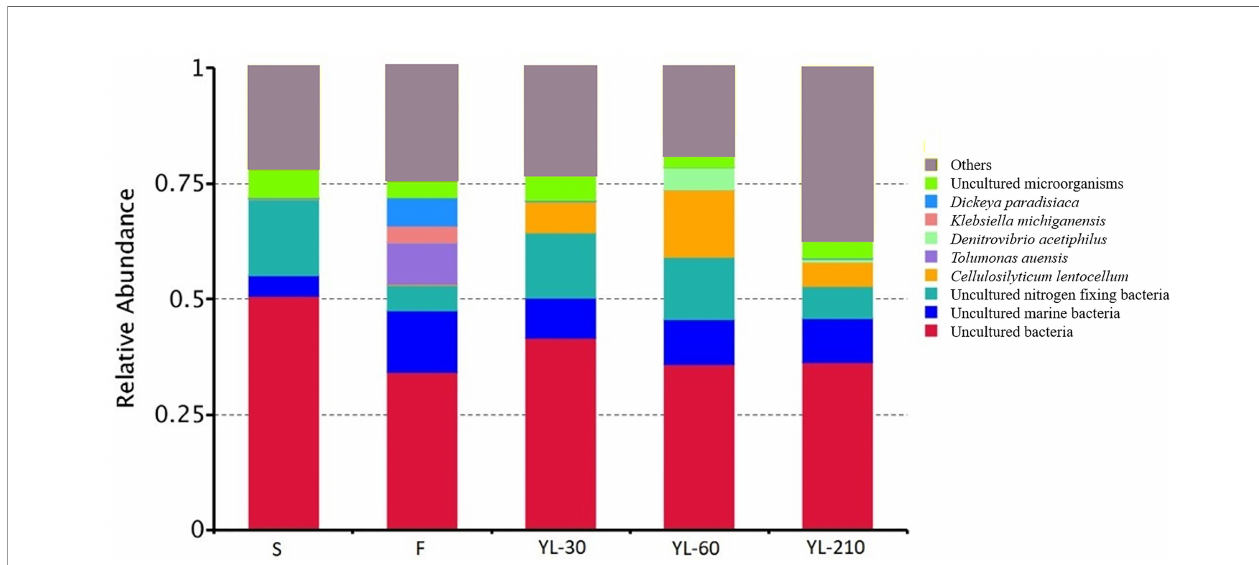
FIGURE 8 | Relative abundance of different bacterial assemblages as indicated by gene sequencing. S, sediment from burrows; F, faeces of crab before feeding with speci fi c diet; YL-30, YL-60, YL-210, feces of crab after feeding on yellow leaves for 30, 60, and 210 days,